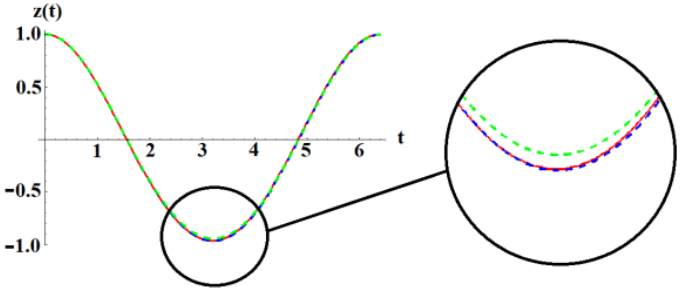
Figure 2. Comparison between the approximate solution (40), the approximate solution (41), and numerical results for Equations (2) and (20): _____ numerical; _ _ _ _Equation (40); _ _ _ _Equation (41).